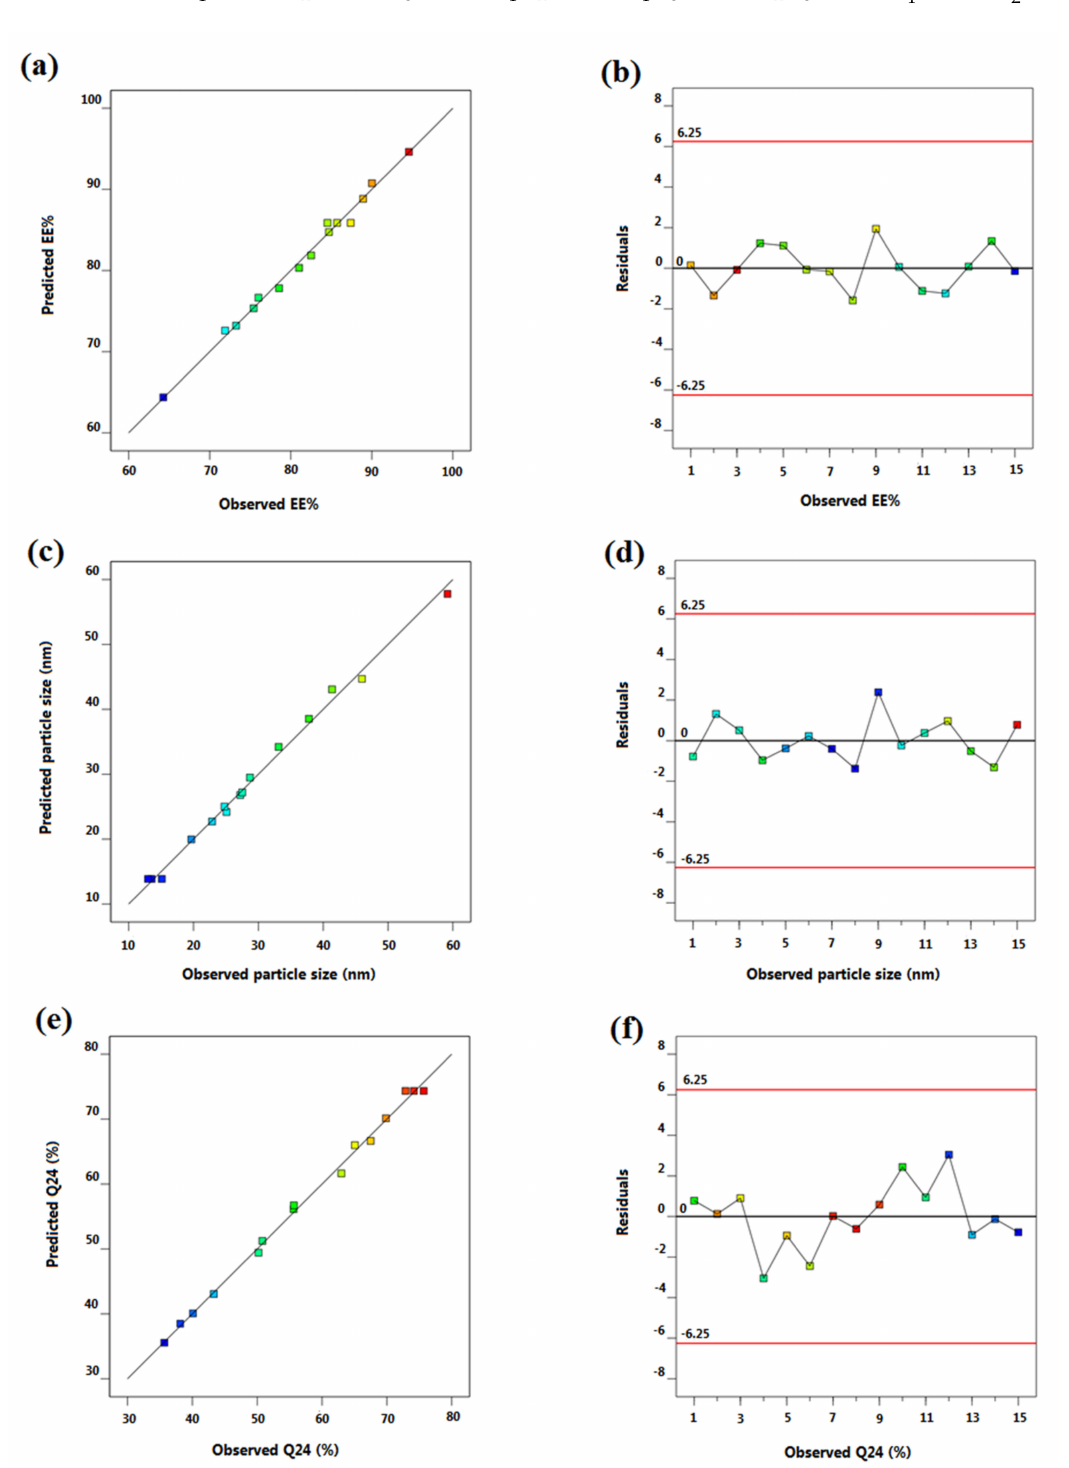
Figure 2. Linear correlation plots ( a , c , e ) between actual and predicted values and the correspondent residual plots ( b , d , f ) for different